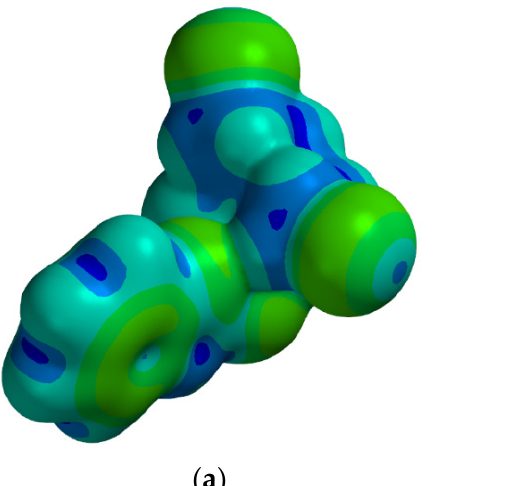
Figure 7. Local ionization map ( a ) and |LUMO| map ( b ) for molecule IX.